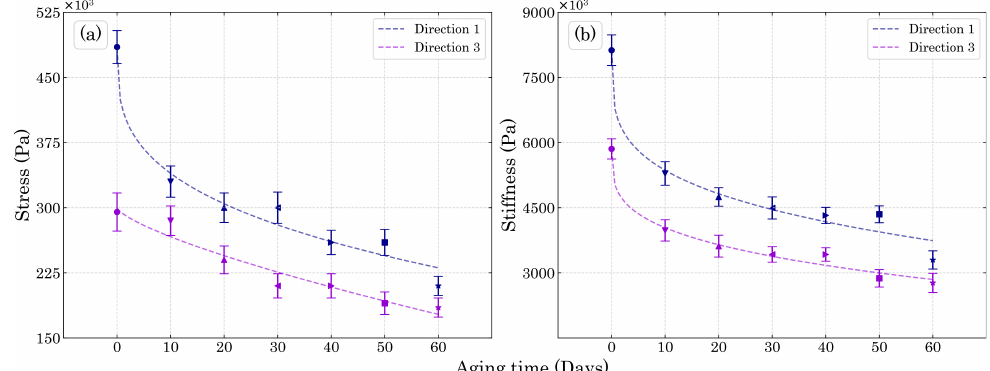
Figure 12. UMAT properties of ( a ) yield stress and ( b ) stiffness for Dir1 and Dir3 with their respective fitting